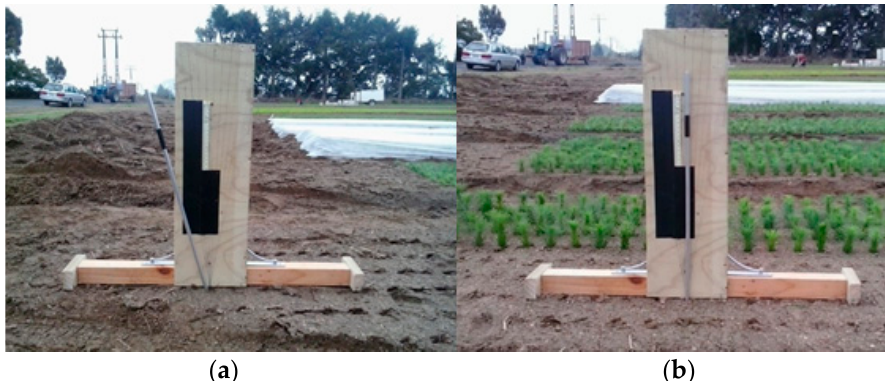
Figure 14. Comparing the hole depth and angle of ( a ) a hole dibbled by a spiked wheel and ( b ) a hole